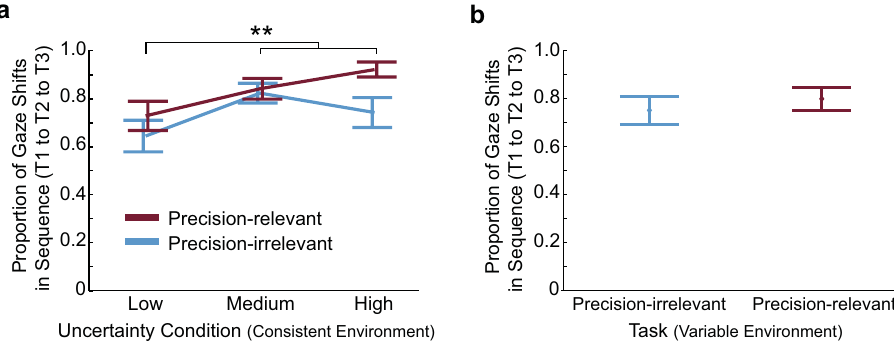
Figure 4. Sequence of gaze shifts. ( a ) Proportion of gaze shifts to sequential targets (T1 to T2 to T3) in the consistent environment with different target uncertainties. ( b ) Proportion of gaze shifts to sequential targets (T1 to T2 to T3) in the variable environment. ** Indicates uncertainty conditions are significantly different from each other (uncertainty main effect: p <